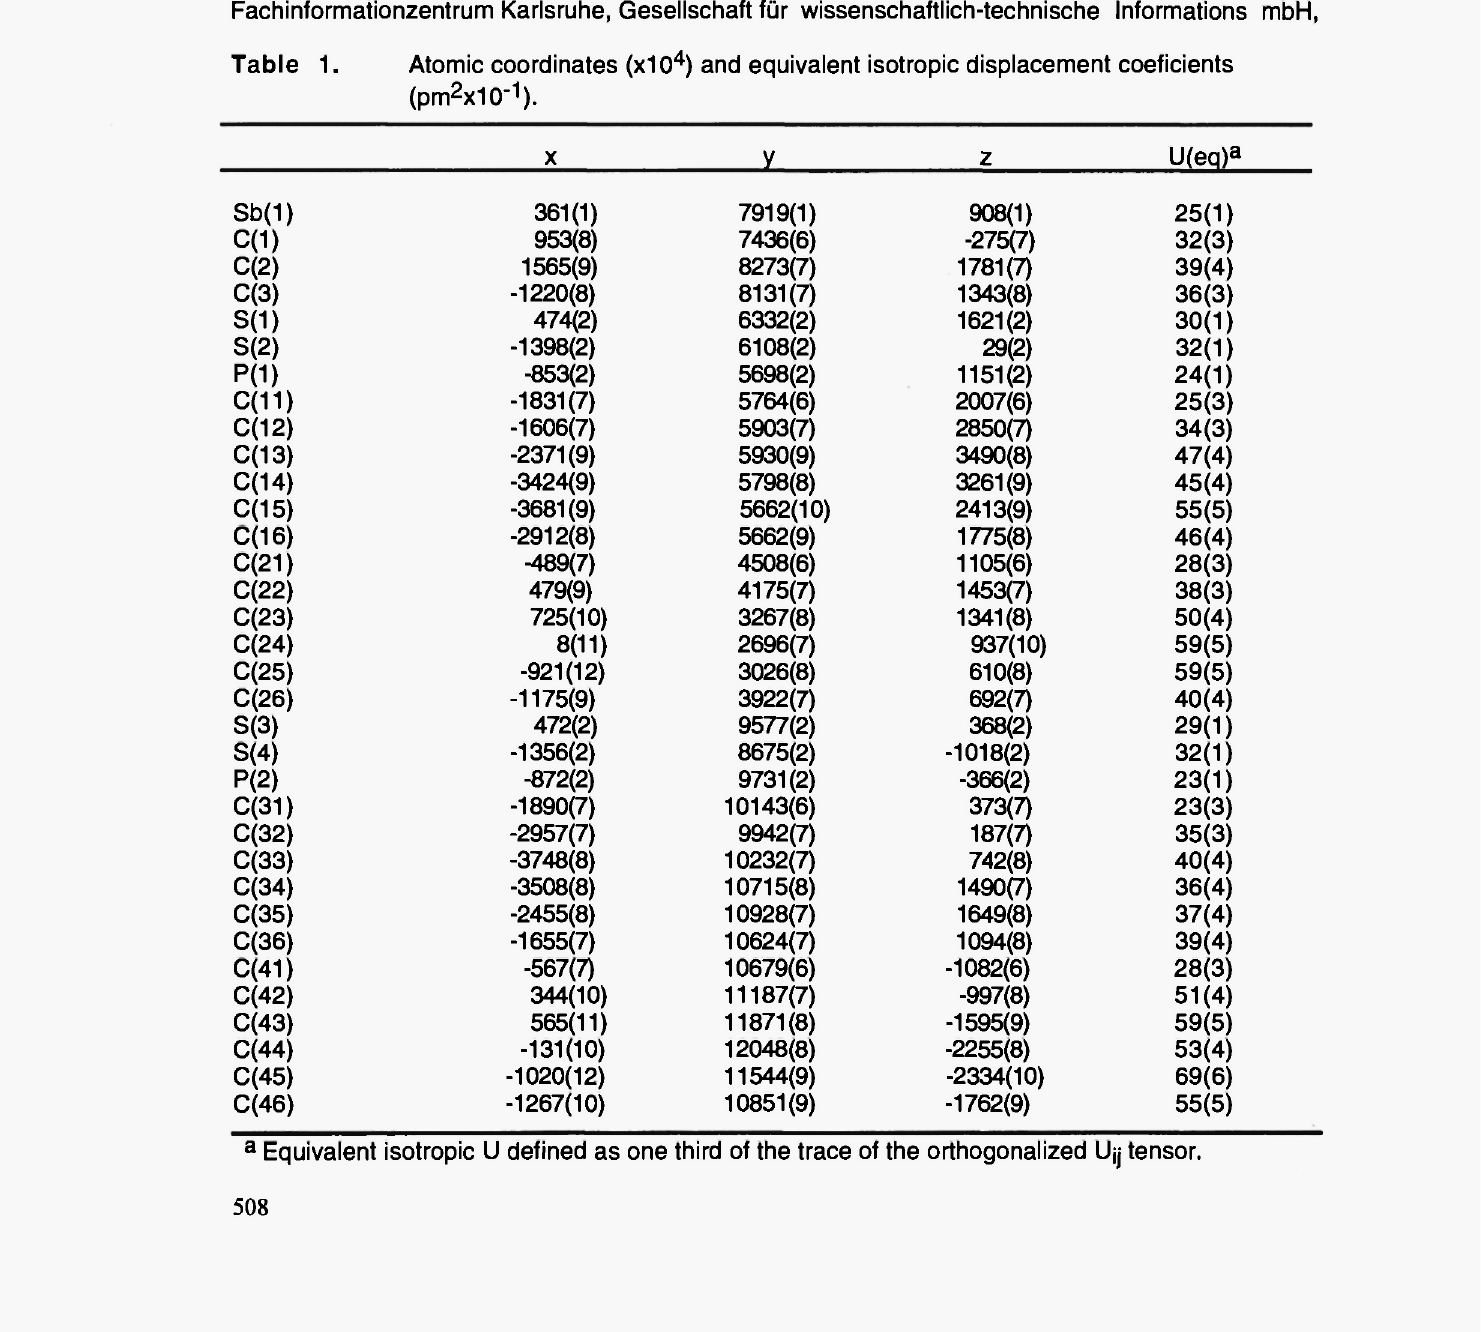
Atomic coordinates (x10 4 ) and equivalent isotropic displacement coeficients (pm 2 x10" 1